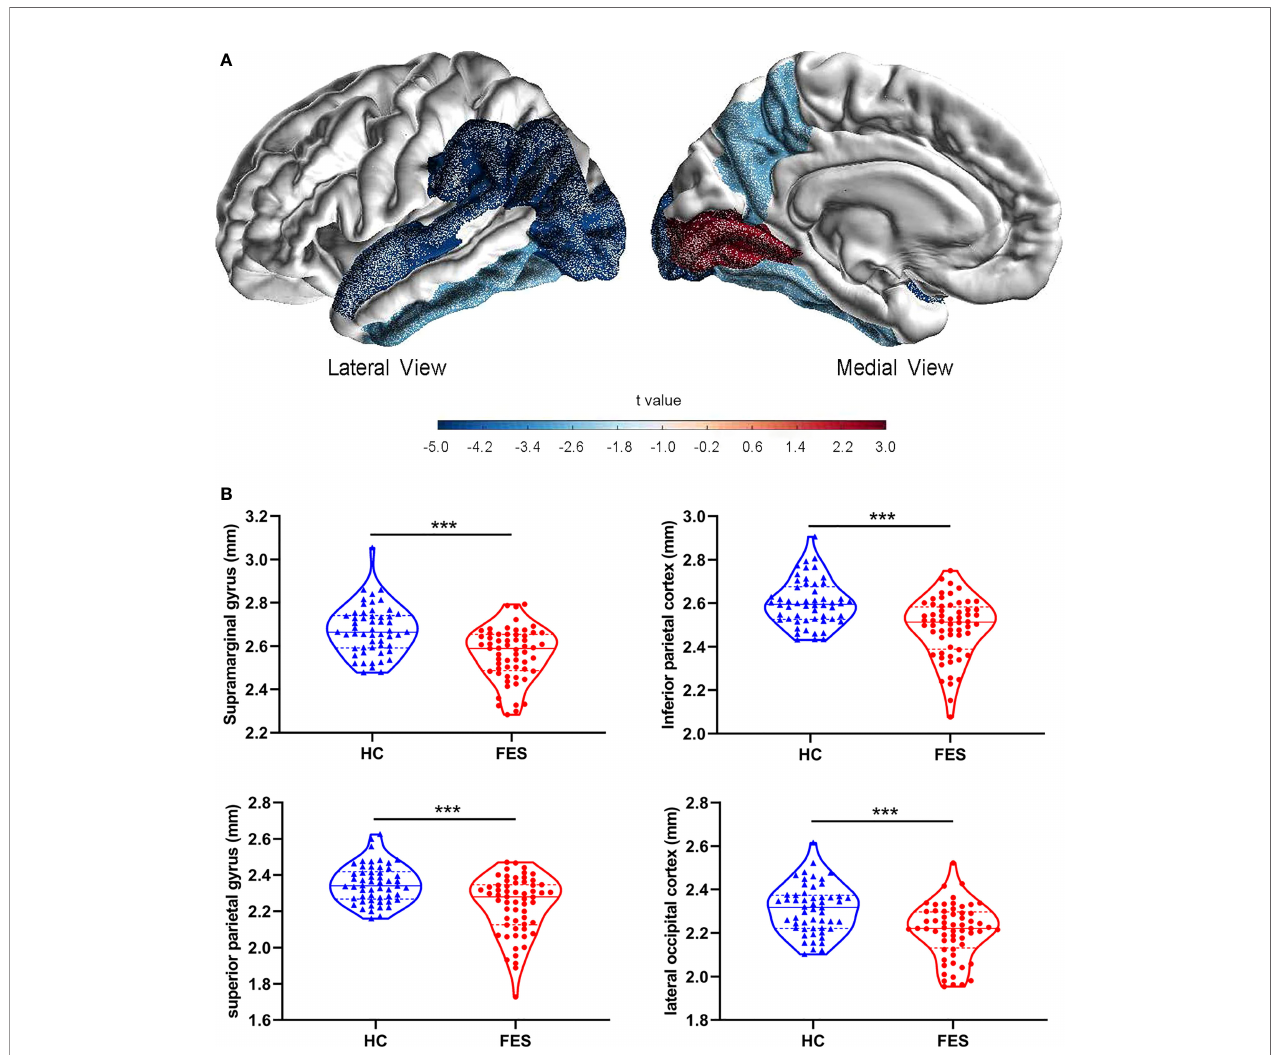
FIGURE 3 | Brain cortical thicknesses are different between FES patients and HCs. (A) Thirty-four distinct gyrus-de fi ned regions per hemisphere were extracted according to the Desikan-Killiany atlas and averaged for both hemispheres in HCs and FES patients. Exemplary MRI images show the cortical regions with signi fi cant group differences in thickness, with blue and red colors encoding cortical thinning and thickening in FES patients as compared to HCs, respectively, after FDR correction and controlling for age and sex. Color gradient is based on the statistical t values of group comparison. (B) Brain regions with the most signi fi cant reduction in cortical thickness of FES patients are shown, with median and upper or lower quartile drawn in violin plots, respectively. *** FDR < 0.001. See also Supplementary Table 7 .